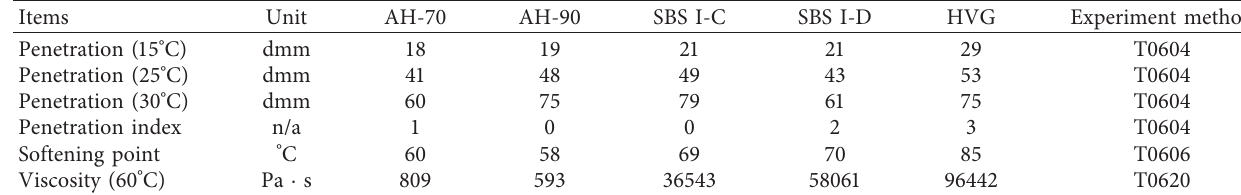
Table 2: Properties of aged binders.